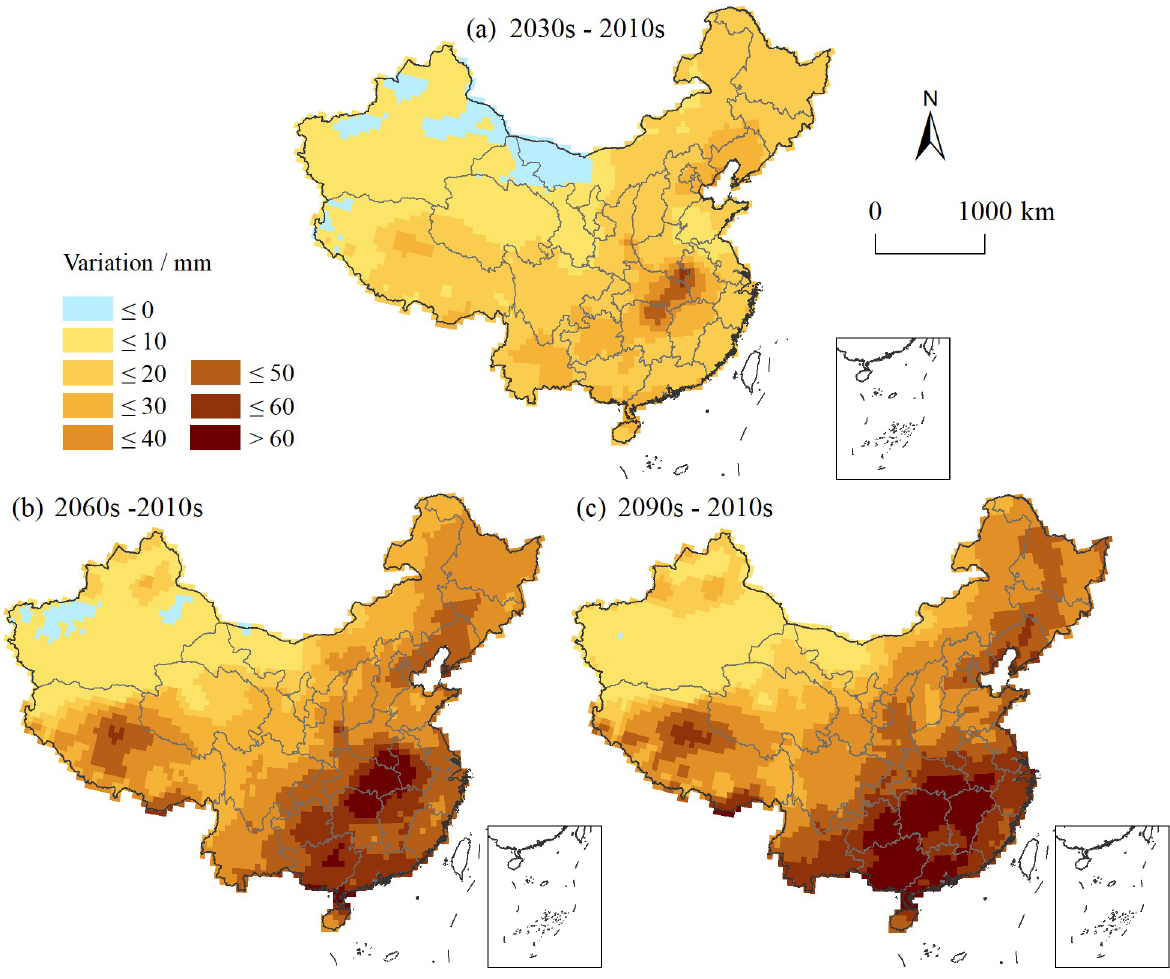
Fig 7. Evapotranspiration during different periods under RCP 4.5. Under RCP 6.0, the available precipitation shows a downward trend in the middle and lower reaches of the Yangtze River and an upward trend in the southwestern and southern regions. In the 2030s, approximately half of the country exhibits a downward trend in the available precipitation, mainly in the northwestern, northeastern, and southern parts of central and eastern China. The available precipitation in southern China is on the rise, and the increase is more than 25 mm. In the 2060s, areas with downward trends noticeably expand, covering almost all of northern, central and eastern China. Among these regions, an obvious decline appears in central and eastern China with a drop of more than 50 mm. South China still shows an upward trend. In the 2090s, areas with a downward trend decrease. The north- eastern region has changed from a downward trend to an upward trend. Although areas with downward trends in central and eastern China decrease, the decline in the available precipita- tion increases. The available precipitation in the Sichuan-Tibet and South China regions obvi- ously increases. The results show that the spatial differentiation increases. Under RCP 8.5, the available precipitation mainly shows an increasing trend. In the 2030s, the increasing trend is obvious in southeastern China, with an increase above 25 mm.